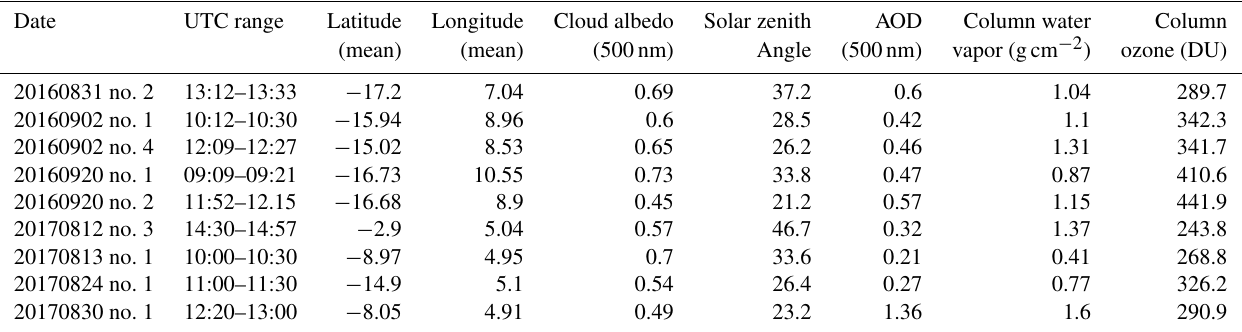
Table 2. Spiral case details for successful aerosol retrievals. The albedo, SZA, AOD, column water vapor, and column ozone are used within the radiative transfer model to retrieve aerosol properties and calculate DARE. The AOD, water vapor, and ozone are all reported above